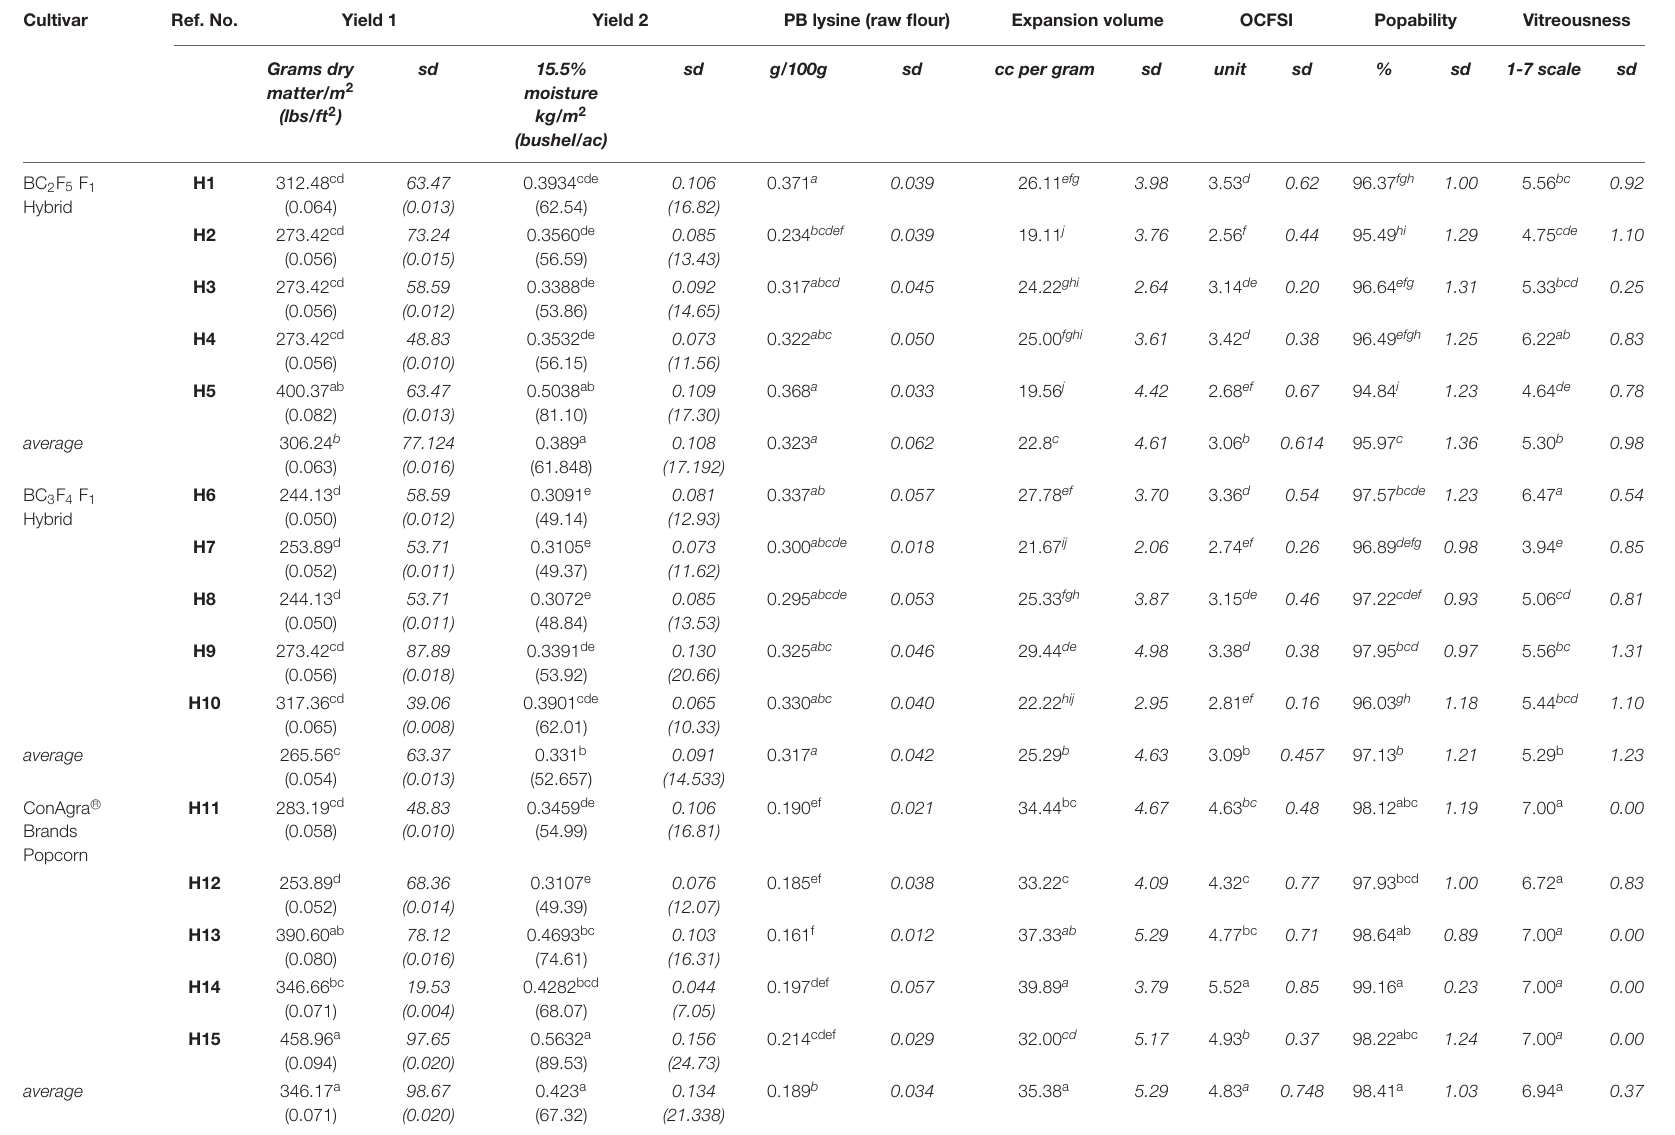
TABLE 2 | Select trait measurements of cultivars tested in 2020 summer trials. Cultivar Ref.